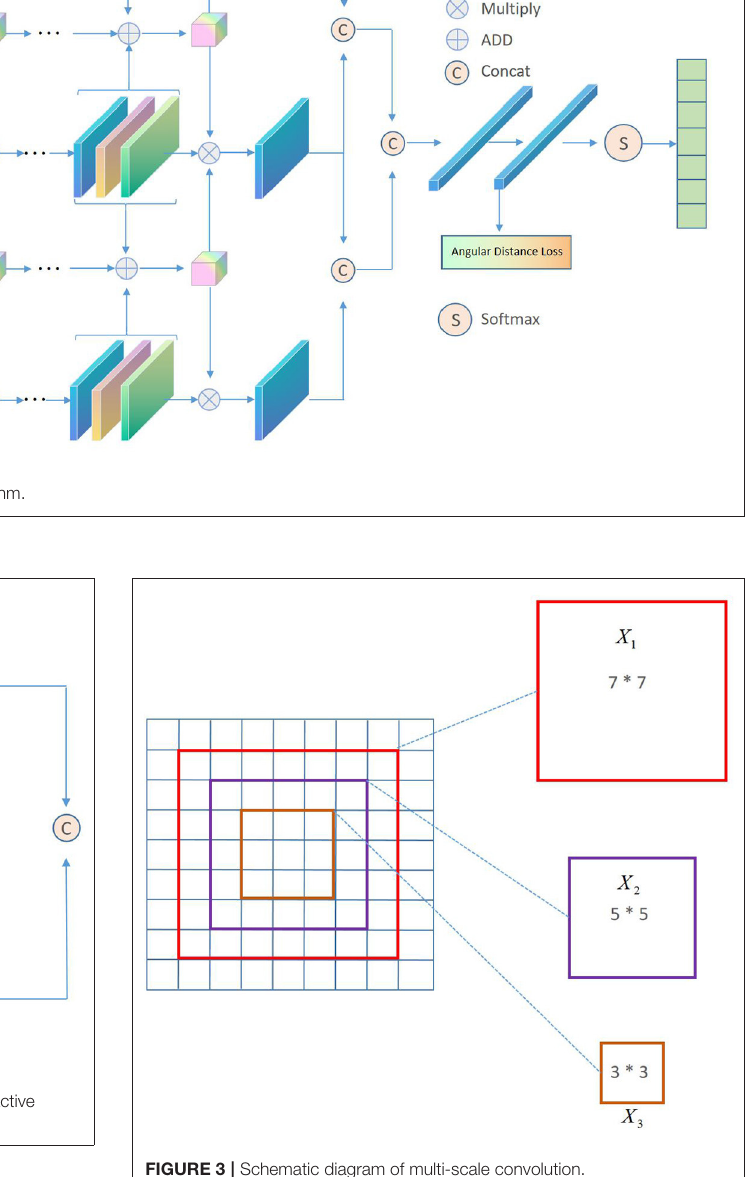
FIGURE 3 | Schematic diagram of multi-scale